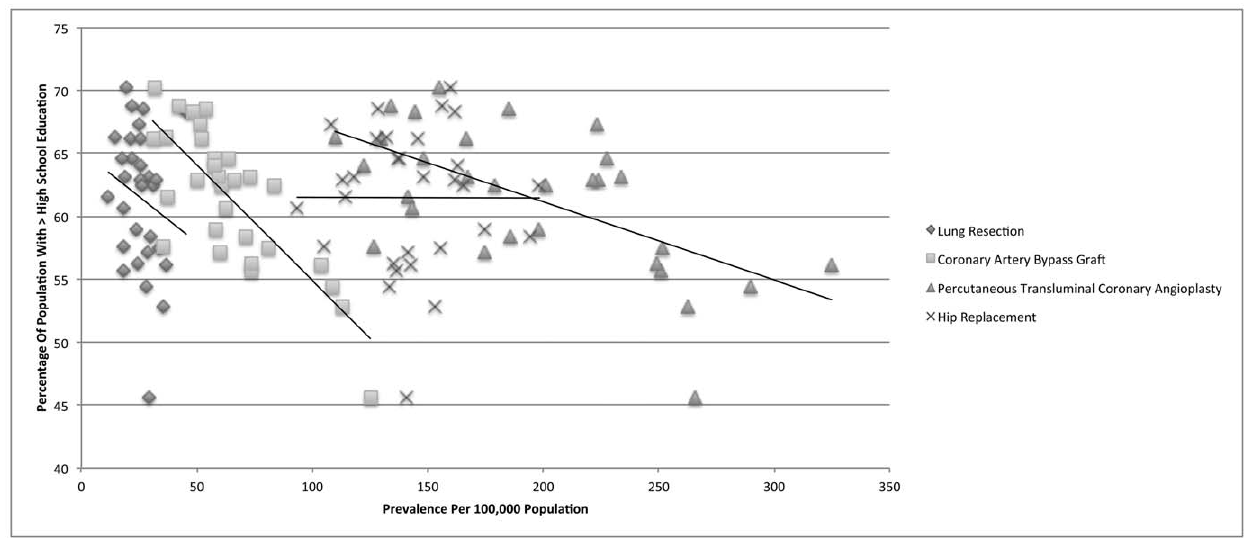
Figure 4. Education level is strongly correlated with the prevalence of advanced coronary artery disease.